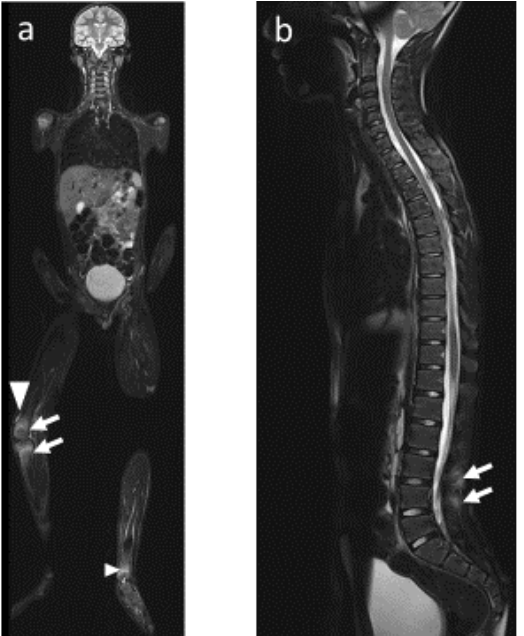
Figure 5. Whole body MRI, same patient 18 months later, CRMO with probable overlapping SpA. Asymmetrical position during MRI acquisition due to intense pain. Coronal plane in ( a ) STIR- weighted sequence showing bone marrow edema in the right lower femur and right upper tibia (arrow), associated with joint effusion (arrowhead) and bone marrow edema in the metaphysis of the left lower tibia (small arrowhead). Sagittal plane in ( b ) STIR-weighted sequence showing peri- osseous edema in the interspinous space (arrows).